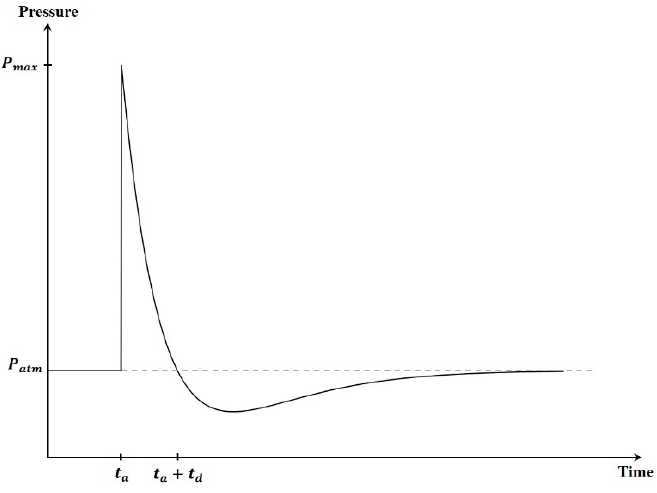
Table 2. Material properties of AISI-4340 [].